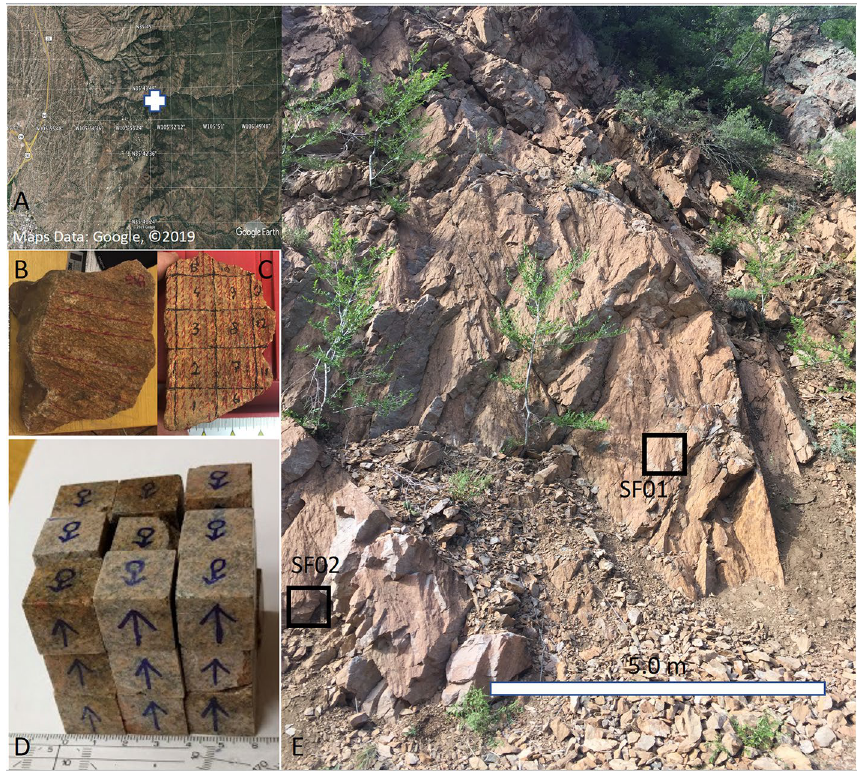
Figure 1. Santa Fe impact structure sample location. ( A ) General location of the Santa Fe structure is just north-east from Santa Fe town, New Mexico, USA. Source: Google earth 7.3.2.5776 (March 5, 2019) Eye alt 20 km. http:// www. earth. google. com [March 10, 2019], Map data: Google, DigitalGlobe, Modified in Adobe Photoshop. The white cross is the sample site located at GPS 35°7279 N. Lat., − 105.8613 W. Lon., Santa Fe Country, New Mexico, USA, ( B , C ) Rocks SF01 and SF02, respectively, sampled from the metamorphosed granitoid along the road 475 (Latitude: 35.7279, Longitude: − 105.8613) that form part of the Santa Fe impact structure. Rocks SF01 and SF02 are 25 cm and 9 cm across, respectively. Photo by G. Kletetschka. ( D ) Cubes cut from the sample in ( B ). Photo by G. Kletetschka. ( E ) Outcrop containing the metamorphosed granitoid of